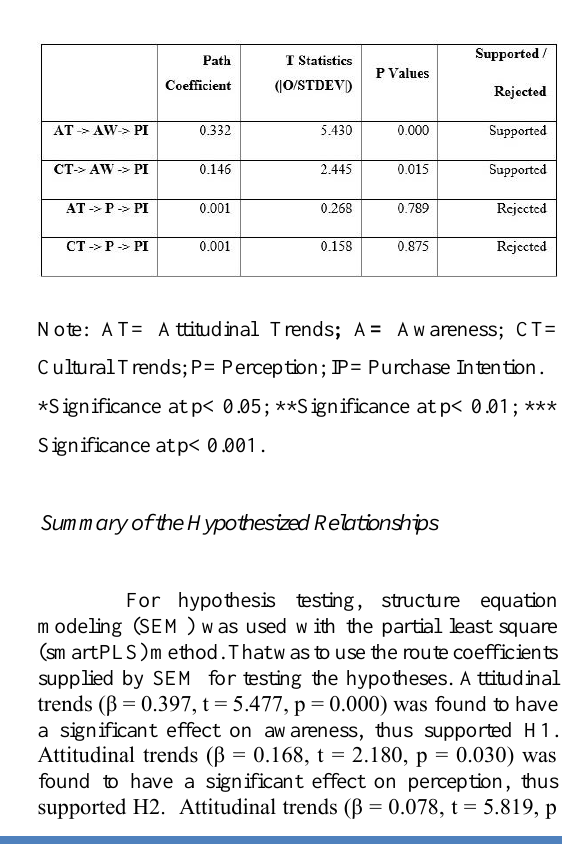
Table 6: Indirect